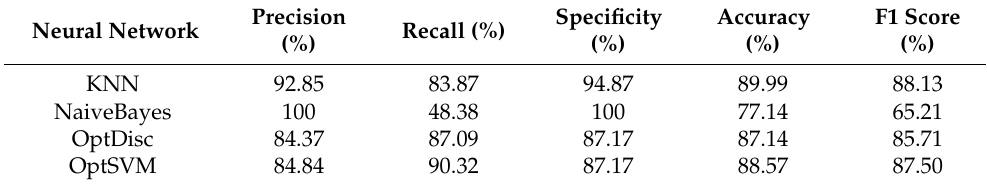
Table 4. Results for different neural networks without considering the noise level (PM10 variant) Precision Specificity Neural Network Recall (%) (%) (%)